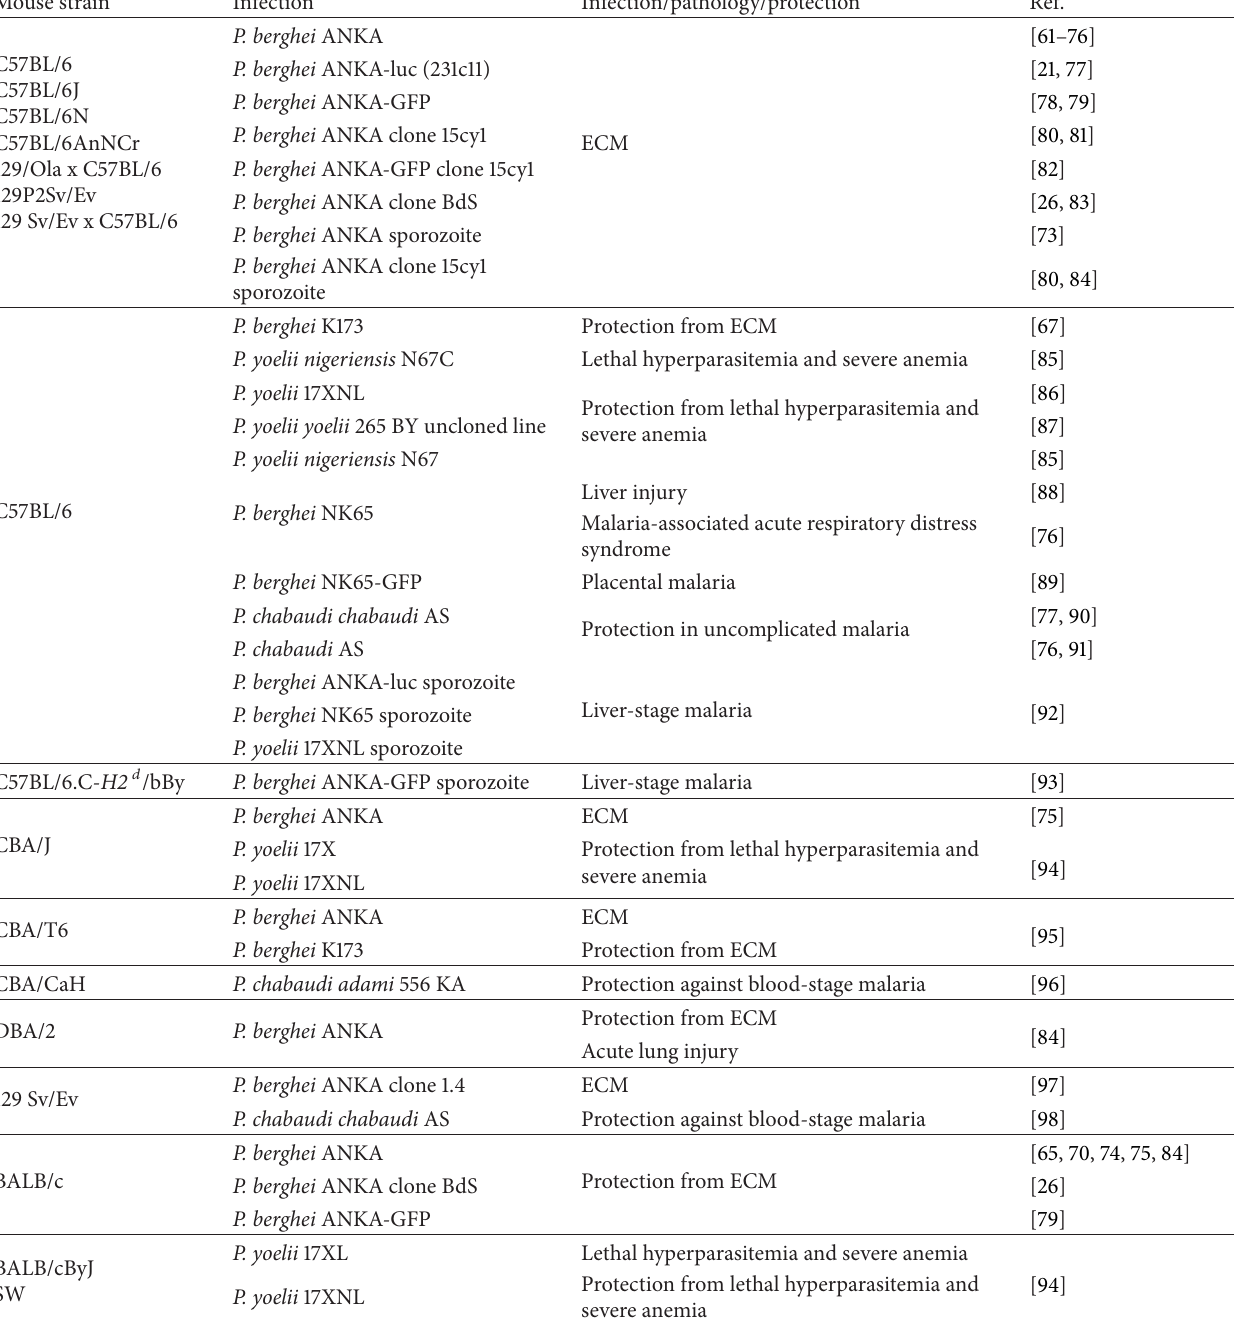
Table 1: Combinations of different mouse backgrounds and parasite strains combinations allow the study of many disease profiles. Mouse